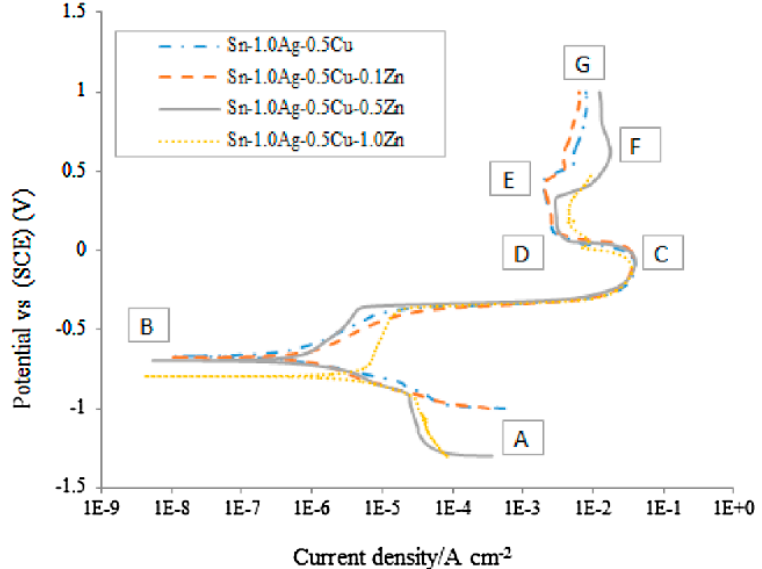
Figure 1. Potentiodynamic polarisation curve of SAC105- X Zn ( X = 0, 0.1, 0.5, 1 wt %) solder alloys in 3.5 wt % NaCl solution [55].